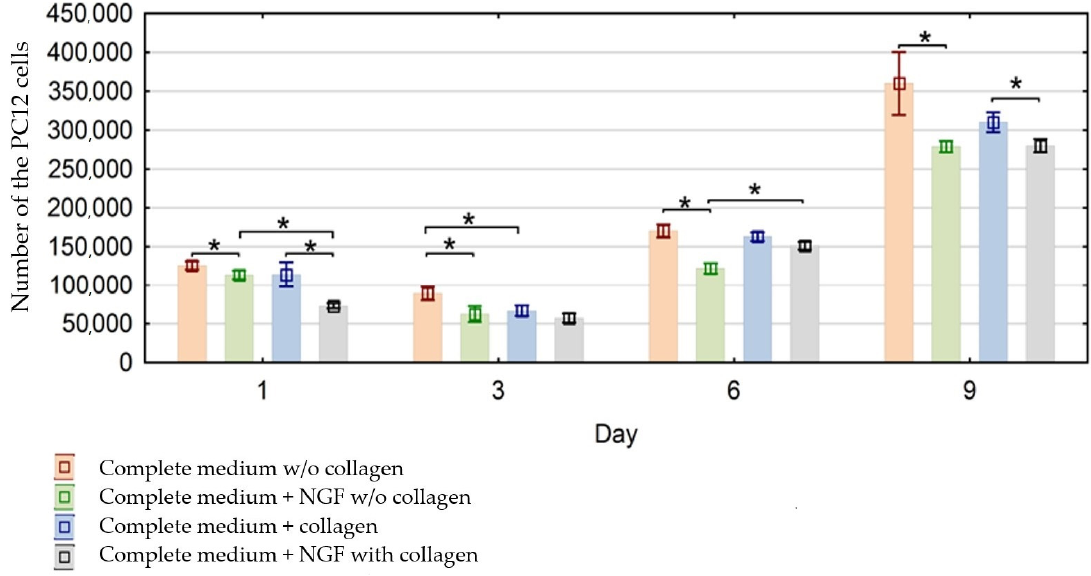
Figure 1. Number of cells in the collected medium (cell cultures without CorMatrix material); * p < 0.05—significant difference in number of